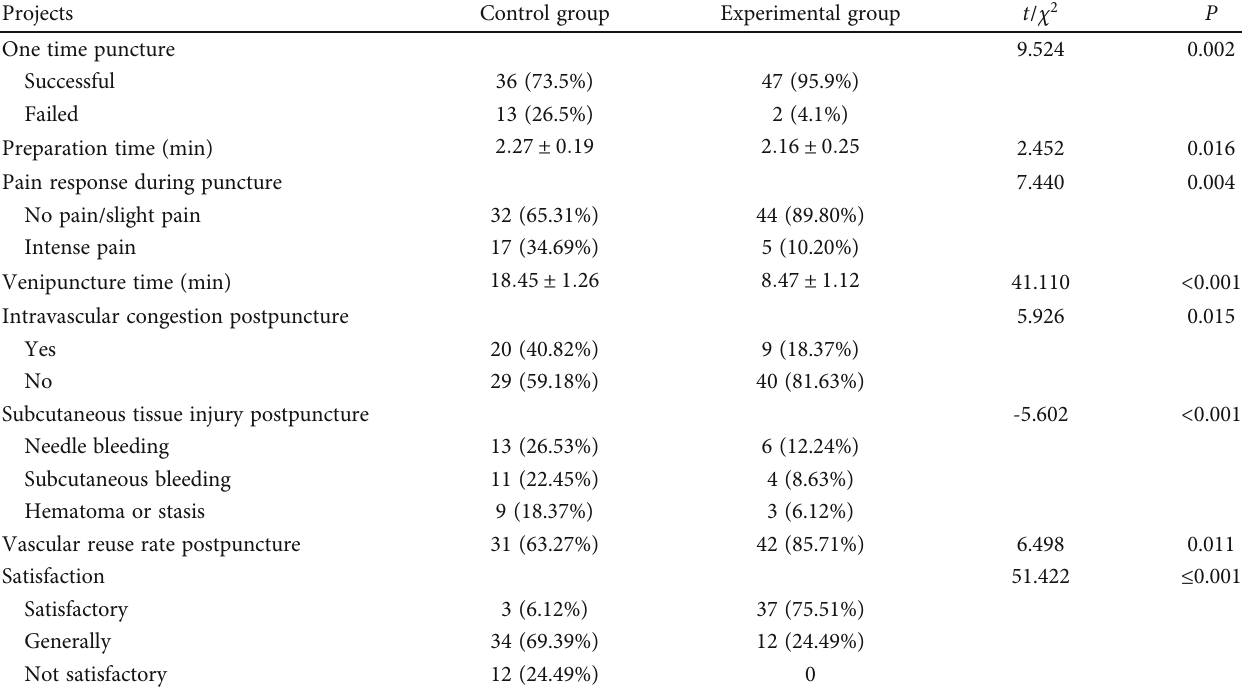
Table 4: Comparison of related indexes of puncture